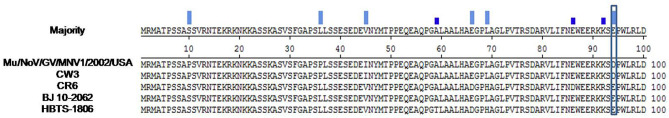
Align sequencs of 1–100 domain of MNV NS1/2 protein construts. The presence of a glutamate at position 94 of the NS1/2 protein could played an essential role in persistent replication and shedding of MNV.